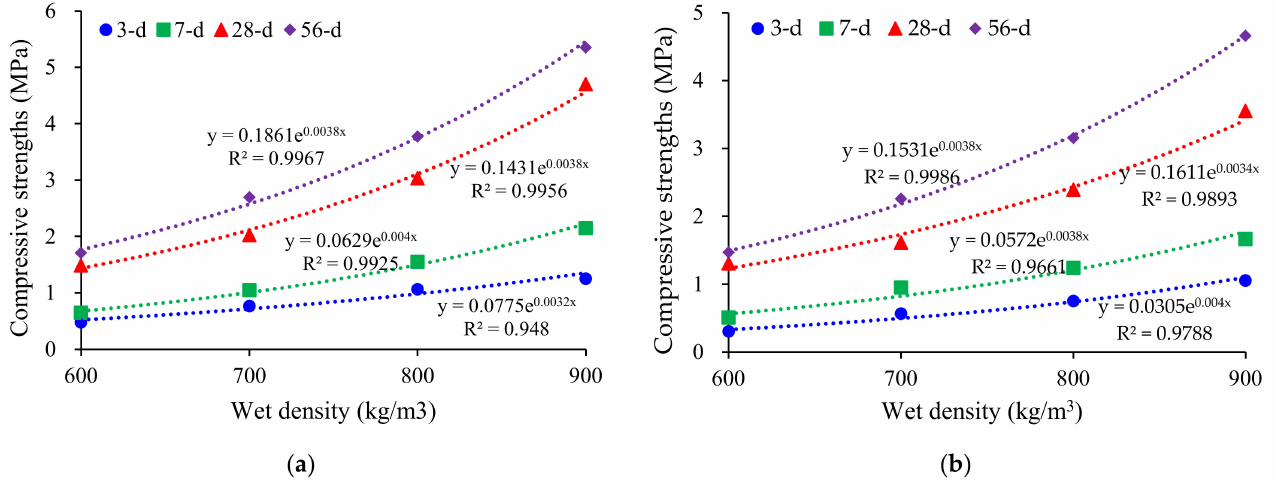
Figure 4. Relationship between the wet density and strength of the mixture: ( a ) LM–FA dosage of 50%; ( b ) LM–FA dosage of 60%.